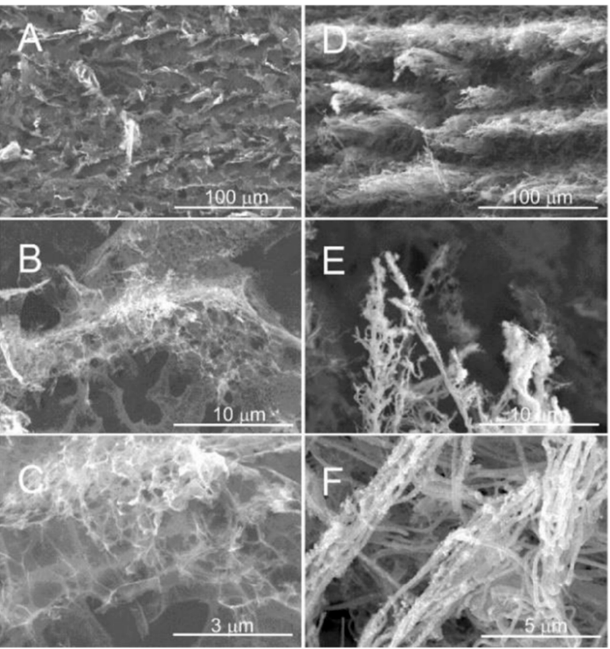
Figure 3. Scanning electron micrograph images of lasered polyimide tracks produced at a power of 7.5 W ( A – C ) and 12.5 W ( D – F ). Reproduced with permission [52].